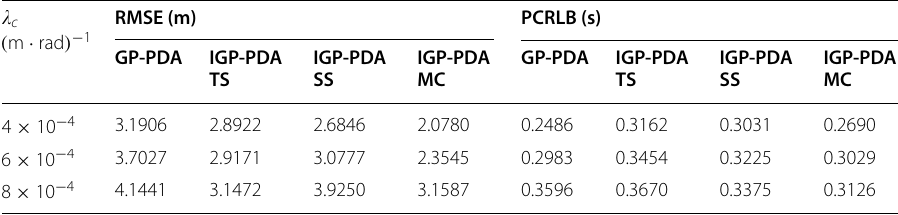
Table 9 Effect of clutter density on centroid estimates RMSE and PCRLB in the second scenario